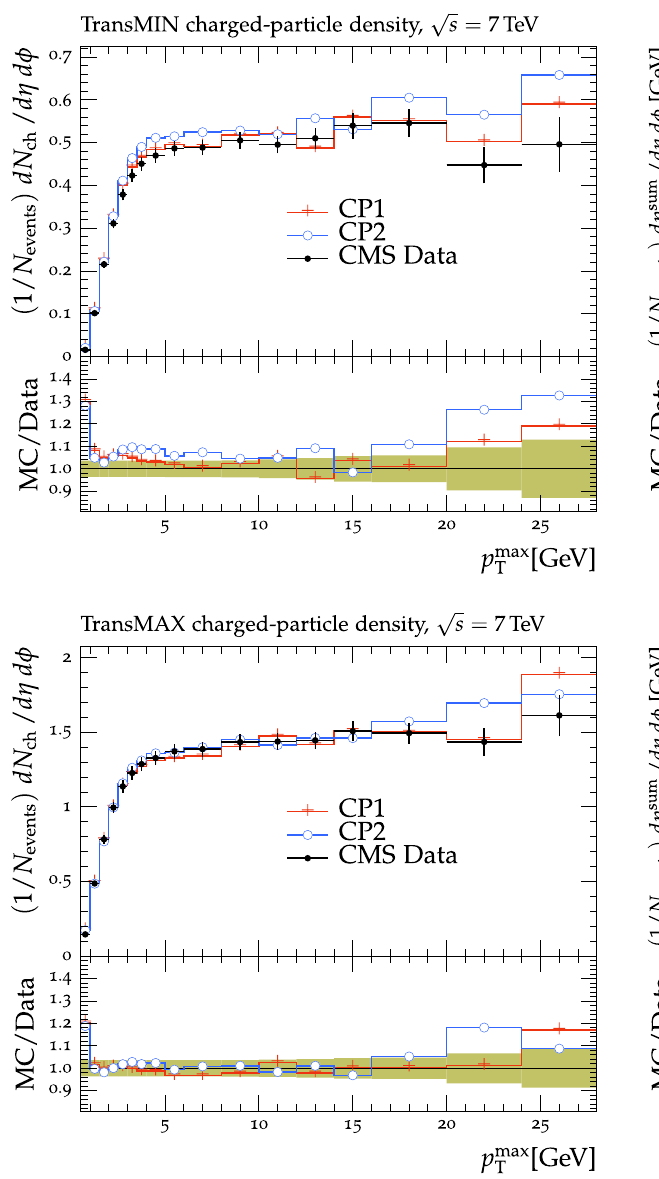
pythia 8 LO-PDF tunes CP1 and CP2. The ratios of simulations to the Fig. 6 The transMIN (upper left) charged-particle and charged p sum T data (MC/Data) are also shown, where the shaded band indicates the (upper right) densities and the transMAX (lower left) charged-particle total experimental uncertainty in the data. Vertical lines drawn on the and charged p sum (lower right) densities, as a function of the trans- T data points refer to the total uncertainty in the data. Vertical lines drawn verse momentum of the leading charged particle, p max , from the √ T s = 7TeV analysis [10]. Charged hadrons are measured with on the MC points refer to the statistical uncertainty in the predictions. CMS p T > 0 . 5GeV in | η | < 0 . 8. The data are compared with the CMS Horizontal bars indicate the associated bin